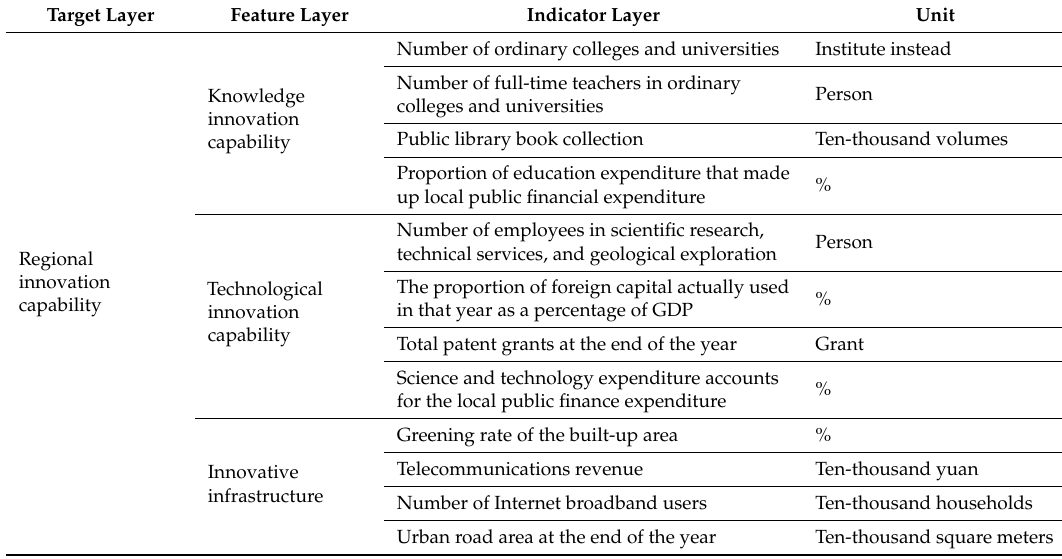
Table 1. Index system for innovation